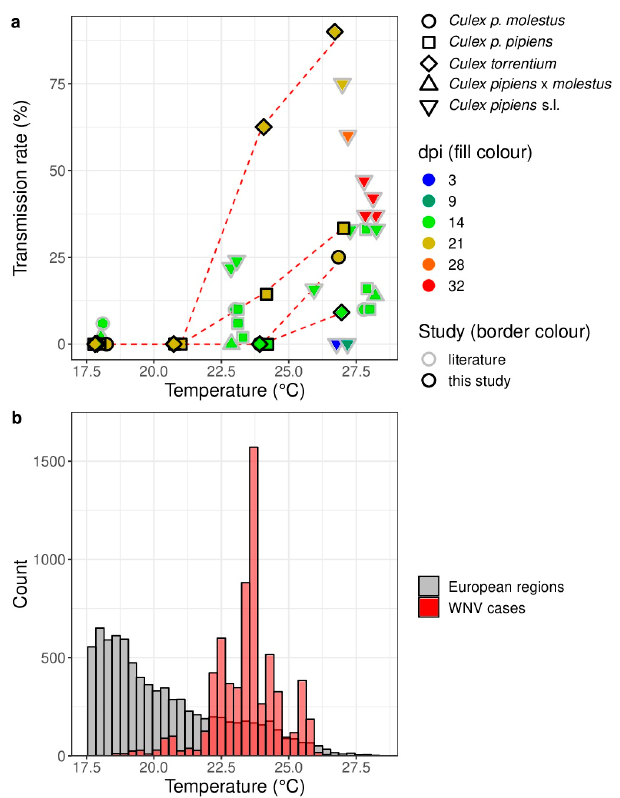
Figure 1. ( a ) Transmission rate of Culex pipiens s.l./ torrentium experimentally infected with West Nile virus at different temperatures and days post infection (dpi) in comparison to previously published vector competence studies with European populations Culex pipiens s.l [21]. A small horizontal jitter was added to the points to prevent overlapping.; ( b ) Histograms of the average temperatures in July/August (2011–2018) for all European NUTS 3 (Nomenclature of Territorial Units for Statistics, third level) regions (=gray) and for each detected human WNV case (=red). Count data for the European NUTS 3 regions indicate the cumulative number of times the respective average temperature in July/August was observed over all European NUTS 3 regions for each year from 2011 to 2018. Only the data for the temperatures between 17.5 °C and 28.5 °C are shown. Similarly, count data for the human WNV cases indicate the cumulative number of times the respective average temperature in July/August was observed for each human WNV case in the respective European NUTS 3 region and year.